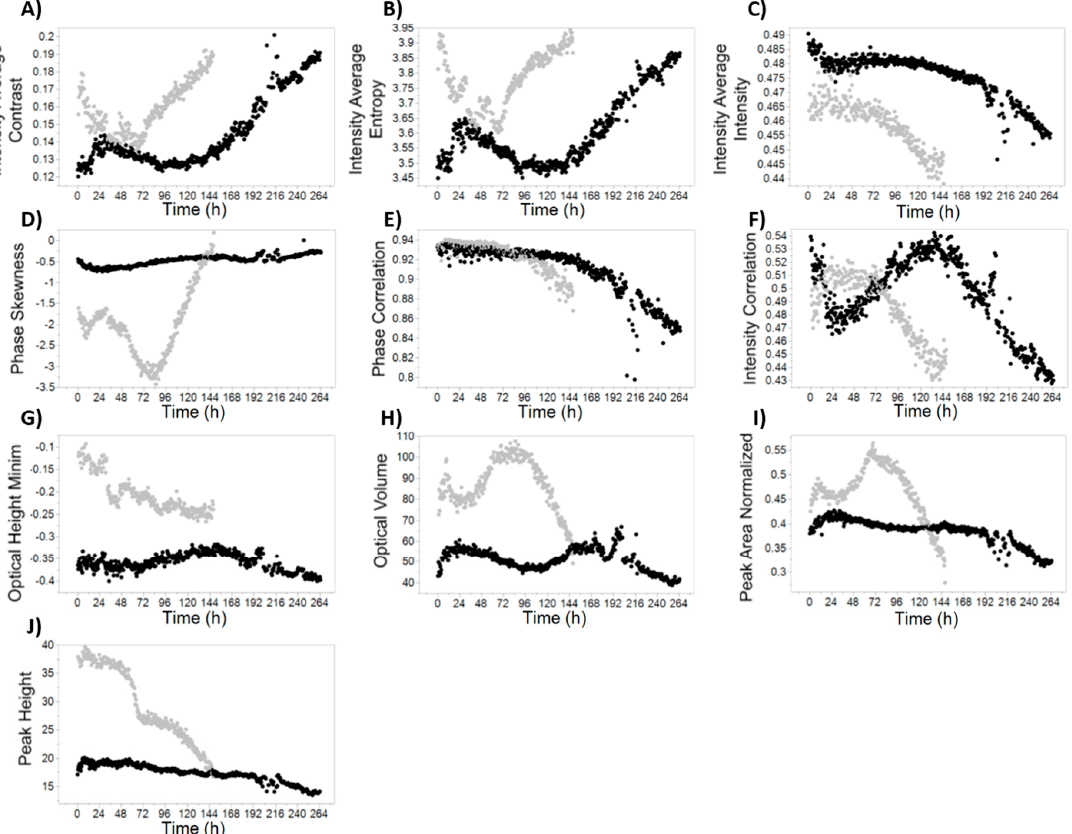
Figure 4. Time-course profiles for selected DDHM attributes. The growth batch is represented in black, while the infected batch is colored in grey. Measurements were obtained every 30 min. ( A ) Intensity Average Contrast; ( B ) Intensity Average Entropy; ( C ) Intensity Average Intensity; ( D ) Phase Skewness; ( E ) Phase Correlation; ( F ) Intensity Correlation; ( G ) Optical Height Minimum; ( H ) Optical Volume; ( I ) Peak Area Normalized; ( J ) Peak Height.